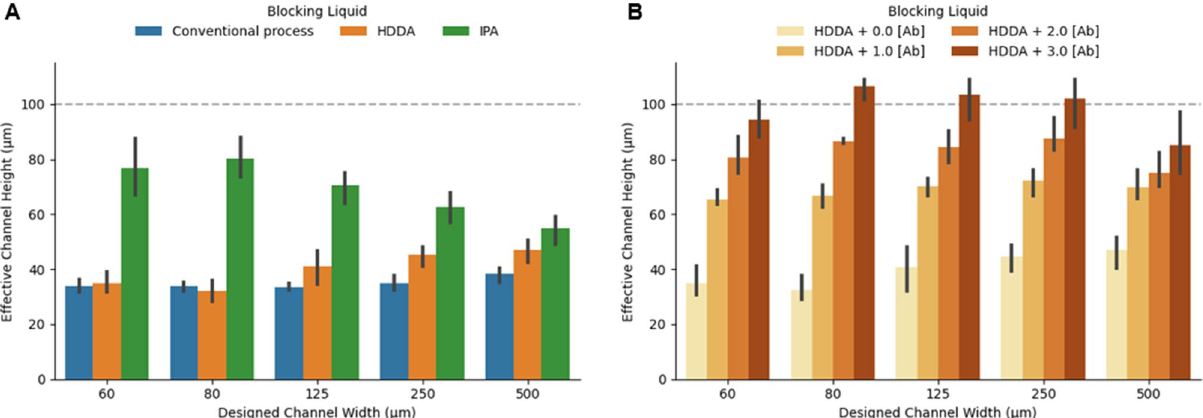
Figure 3. The effect of blocking liquid formulation on the effective channel height. ( A ) Comparisons of the two different blocking liquids to the conventional process. ( B ) The effect of Sudan I absorber concentration, [Ab], in HDDA blocking liquid. In ( A ) and ( B ), the designed channel height is shown as horizontal dashed lines, the principal exposure dose was four times higher than regular exposure dose, and the error bars represent standard deviation of process repeatability for n = 3